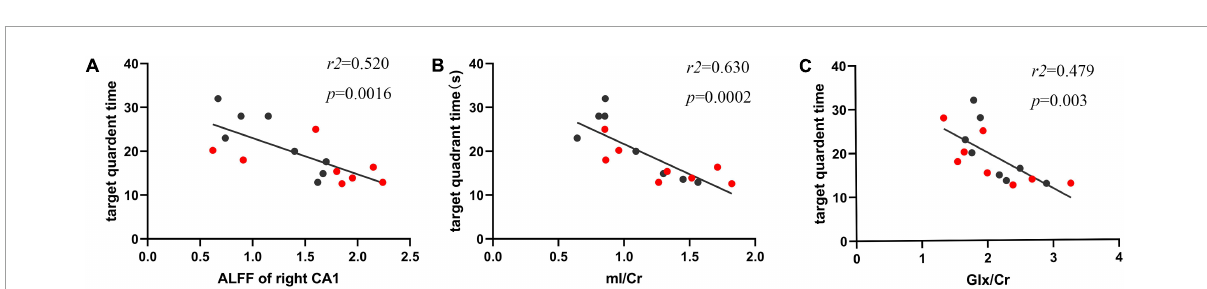
FIGURE6 The ALFF values and metabolites in the hippocampus were negatively correlated with duration in the target quadrant. (A) The ALFF value of the right CA-1 was negatively correlated with total time spent in the target quadrant ( r 2 = 0.520, p = 0.0016). (B) The mI/Cr ratio was negatively correlated with target time spent in the target quadrant ( r 2 = 0.630, p = 0.0002). (C) The Glx/Cr ratio was negatively correlated with total time spent in the target quadrant ( r 2 = 0.479, p = 0.003). The red samples represented the rats from day 7 post CLP group, and black samples from day 14 post CLP